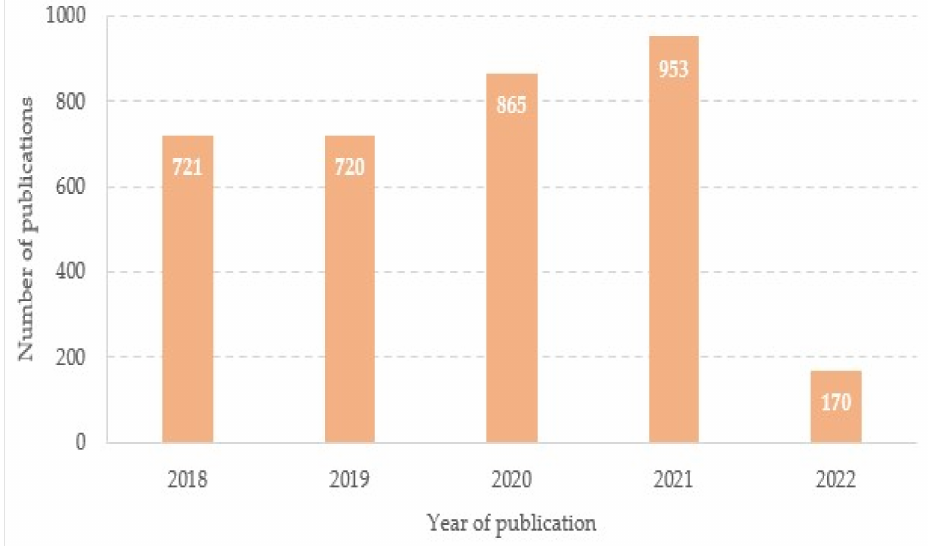
Figure 3. Year-wise distribution of